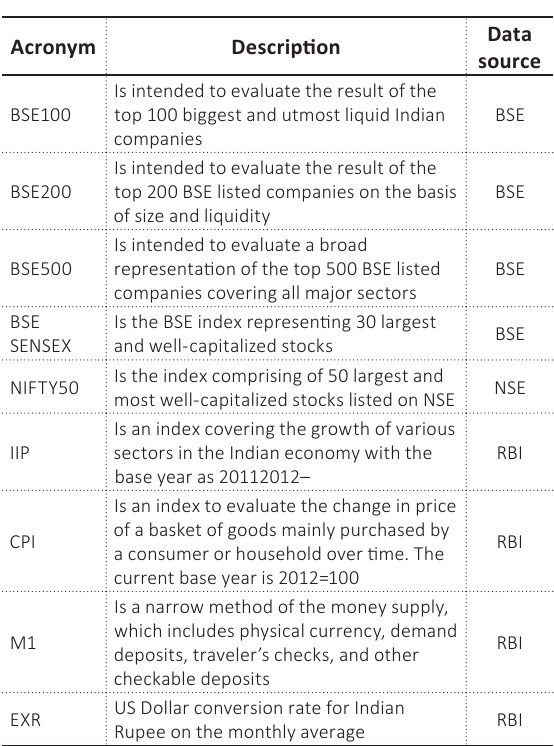
Table 1. Description of